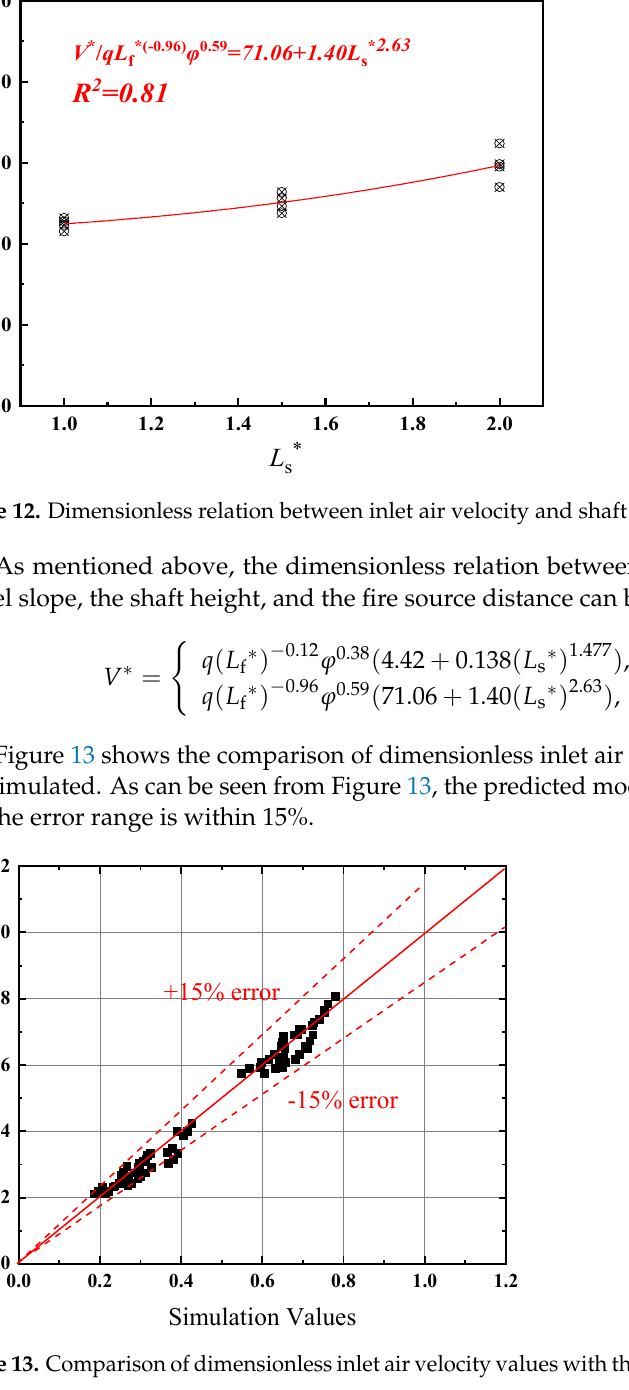
Figure 11. Dimensionless relation between inlet air velocity and shaft height ( L f ≤ 330 m).